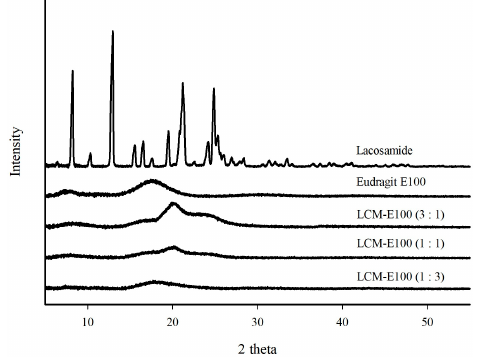
Figure 2. PXRD diffractograms of lacosamide, Eudragit E100, LCM-E100 (3:1), LCM-E100 (1:1) and LCM-E100 (1:3).